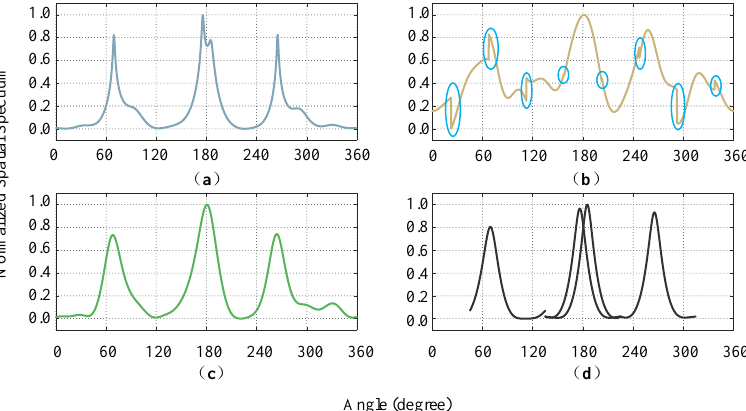
Figure 5. Spatial spectrum for different algorithms: ( a ) DA-MUSIC, ( b ) S-MUSIC, ( c ) Capon-like, and ( d ) two-stage fast DOA estimation.